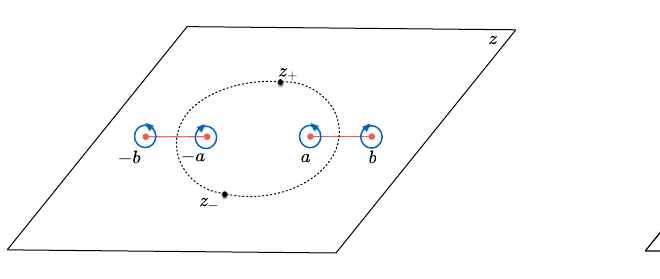
Figure 3 . Shown are two coordinate systems describing the same reduced density matrix for two intervals. On the left is the z plane that has been cut open along the two intervals. The blue circles are boundaries of disks that have been removed from the UV regulated spacetime, with the arrows indicating direction of the modular (cid:13)ow. In the w coordinates, the same background is represented as a double cover with branch points at w (cid:6)